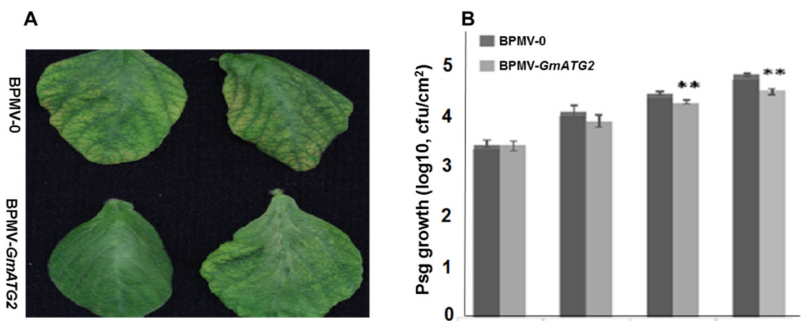
Figure 5. Silencing GmATG2 results in enhanced resistance of soybean plants to Pseudomonas syringae pv. glycinea ( Psg ). ( A ) Comparison of the symptoms on the BPMV- ATG2 plants and BPMV-0 plants caused by Psg infection at 9 days post inoculation. ( B ) The Psg growth curves on the leaves of BPMV-0 plants and GmATG2 -silenced plants at different days of post Psg inoculation (dpi). ** indicates significant difference at 0.01 level by Student’s t -test. This experiment was repeated at least 3 times with similar result. At least 3 plants were used in each repeat.